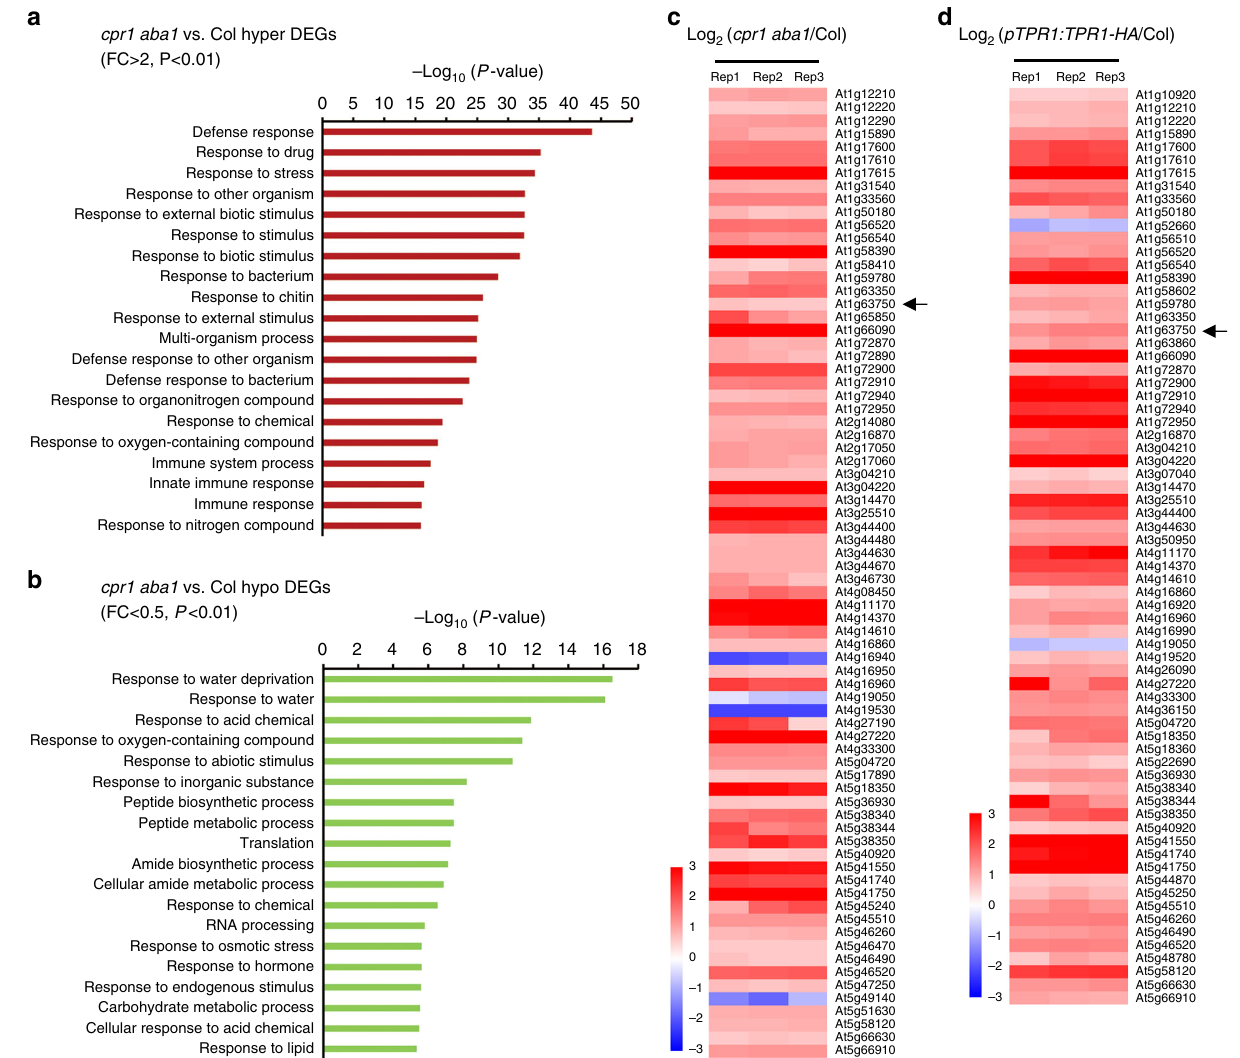
Fig. 8 Widespread induction of NBS-LRR genes in cpr1 aba1 . a The top 20 GO terms for up-regulated genes (hyper DEGs) in cpr1 aba1 as determined by RNA-seq. R genes with RPM > 10 in either cpr1 aba1 or wild type (average of three replicates) were used for the identi fi cation of hyper DEGs (fold-change > 2, P value < 0.01). The hyper DEGs are enriched for genes involved in stress responses, particularly defense responses. b The top 19 GO terms for downregulated genes (hypo DEGs) in cpr1 aba1 . R genes with RPM > 10 in either cpr1 aba1 or wild type (average of three replicates) were used for the identi fi cation of hypo DEGs (fold-change< 0.5, P value < 0.01). GO terms in various small molecule biosynthetic and metabolic processes are enriched in the hypo DEGs. c Analysis of R gene expression in three biological replicates (rep1 – 3) of RNA-seq of cpr1 aba1 and wild type (Col). Only DEGs with fold- change > 1.5, P value < 0.05 and RPM > 10 in either genotype (average of three replicates) were included in the analysis. Among the DEGs, 70 and 4 were upregulated and downregulated, respectively, in cpr1 aba1 relative to Col. The arrow marked an R gene (At1g63750) that could generate phasiRNAs. d Analysis of R gene expression in three biological replicates (Rep1 – 3) of RNA-seq of pTPR1:TPR1-HA and wild type (Col). Only DEGs with fold-change > 1.5, P value < 0.05 and RPM > 10 in either genotype (average of three replicates) were included in the analysis. Among the DEGs, 68 and 2 were upregulated and down-regulated, respectively, in pTPR1:TPR1-HA relative to Col. The arrow marked an R gene (At1g63750) that could generate